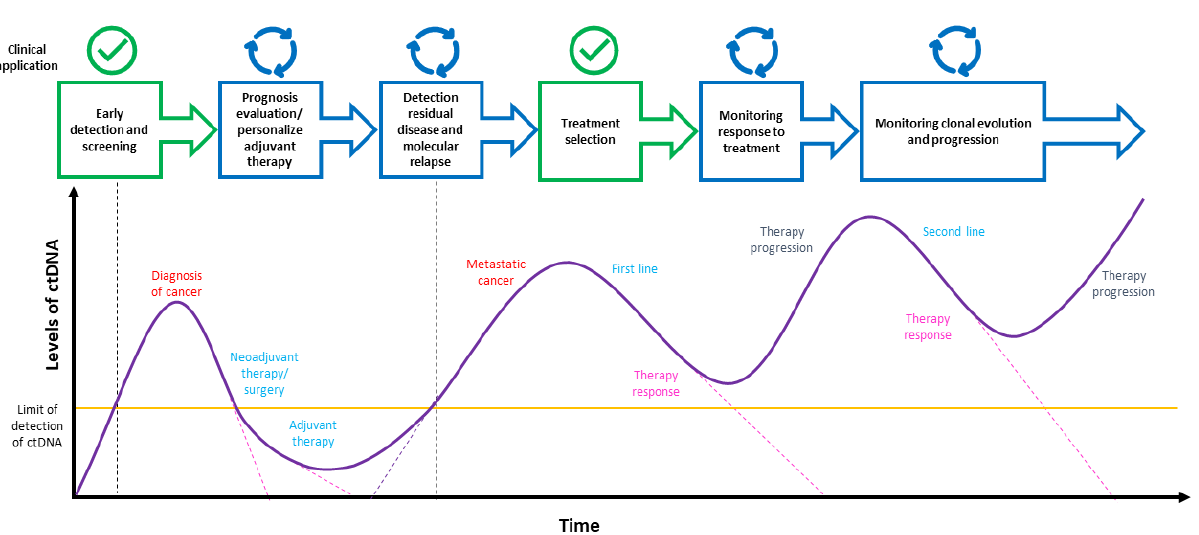
Figure 2. A schematic view of clinical applications of ctDNA liquid